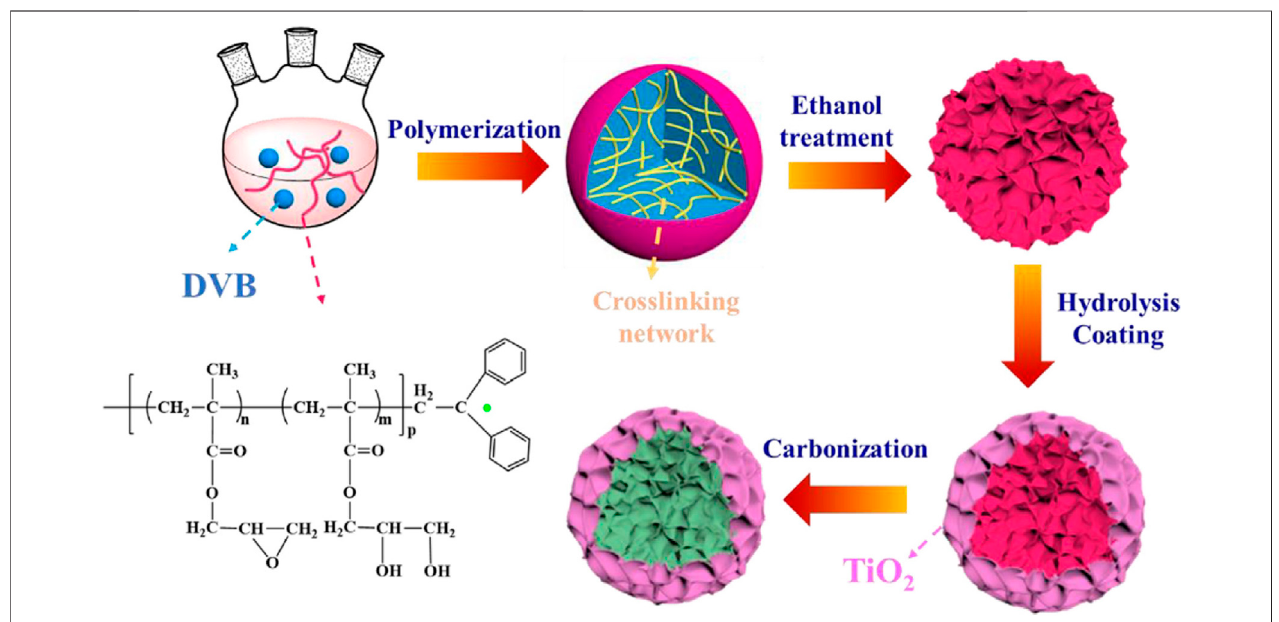
FIGURE 3 | Preparation fl ow chart of core-shell C@TiO 2 microspheres prepared by a three-step method. Adapted from Xu et al. (2022). Copyright © 2020 Elsevier Ltd.